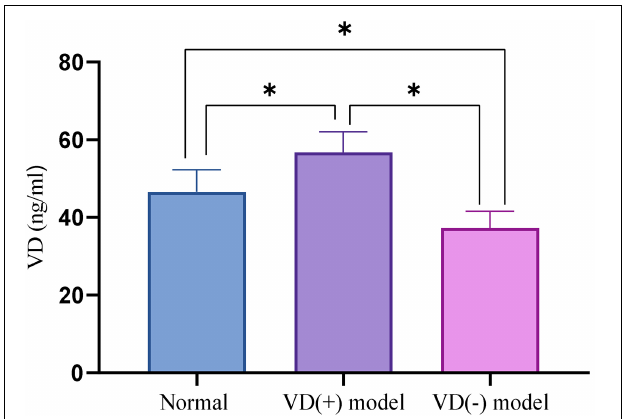
FIGURE 1 | Comparison of VD content after successful modeling, ∗ P < 0.05.